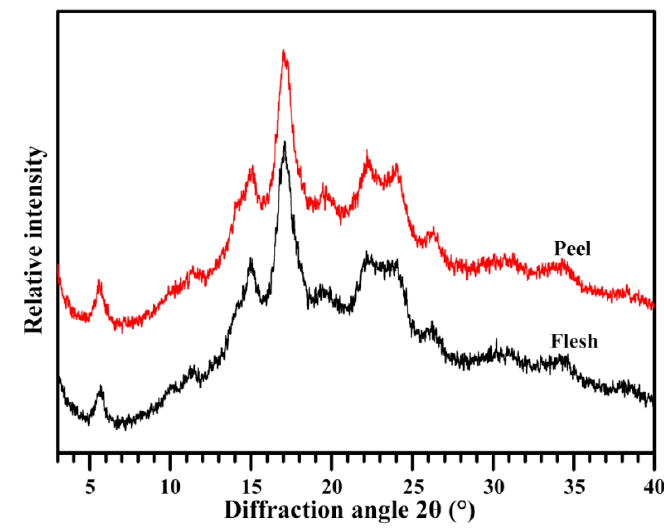
Figure 3. XRD patterns of starches.